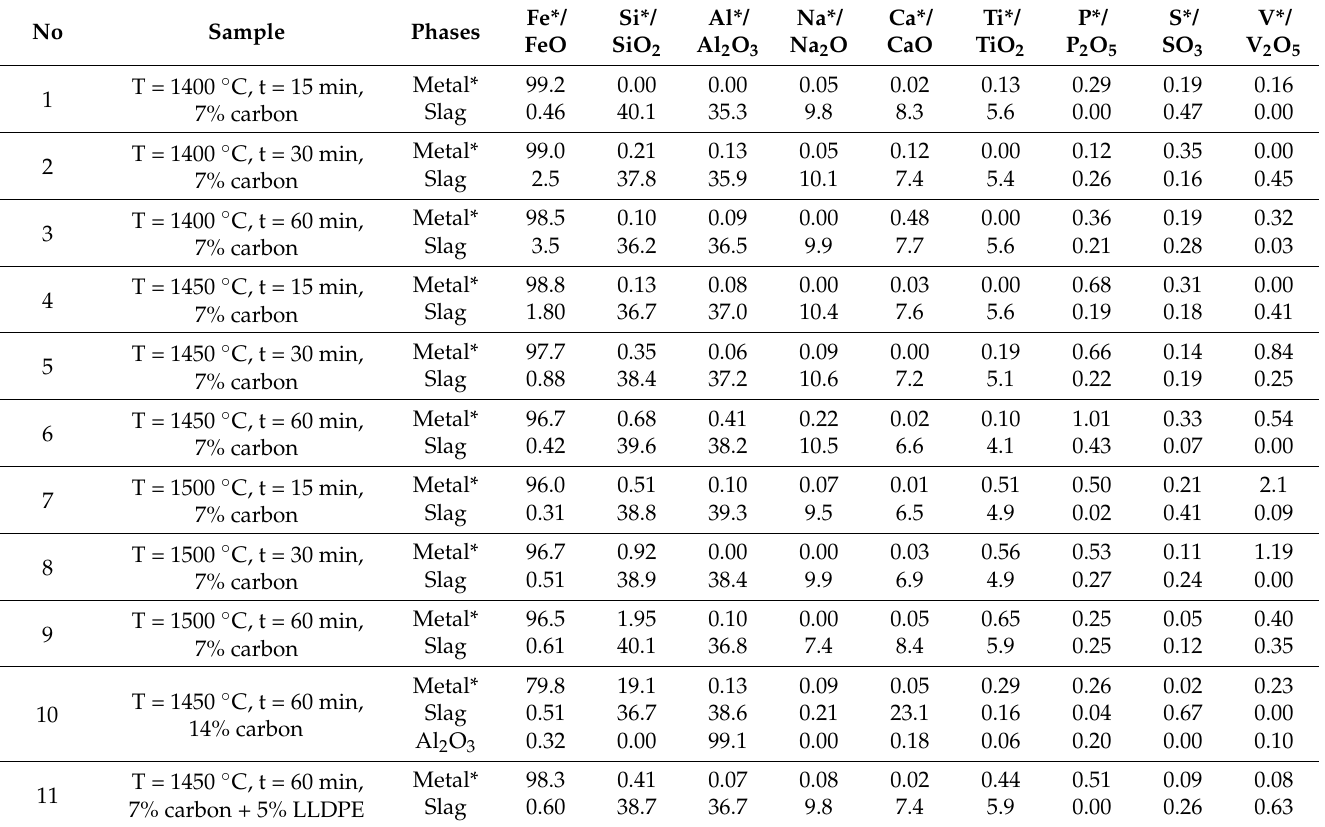
Table 2. EDS measured compositions (in wt.%) of phases in samples from the high-temperature reduction of red